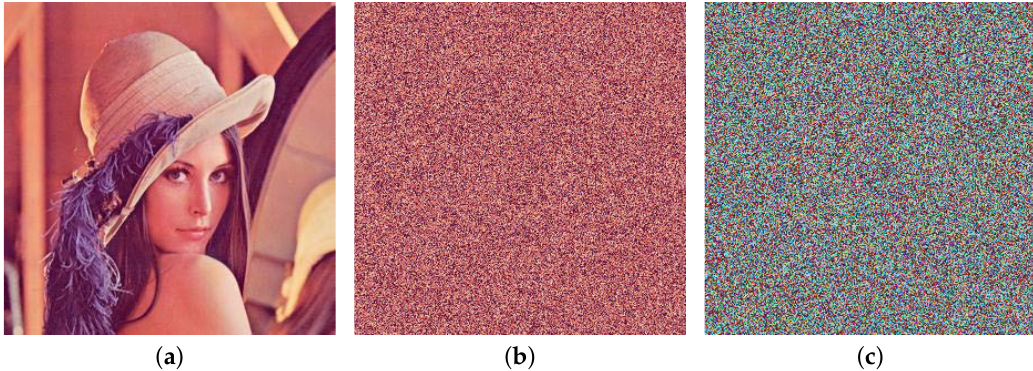
Figure 9. ( a ) original image; ( b ) encrypted image after chaos scrambling; ( c ) encrypted image after chaos XOR (exclusive-or)